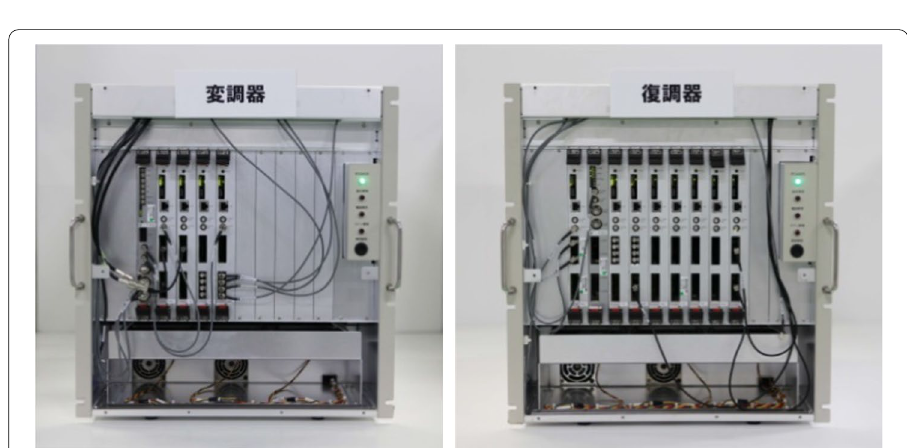
Fig. 3 Modulator (left) and demodulator (right) used for